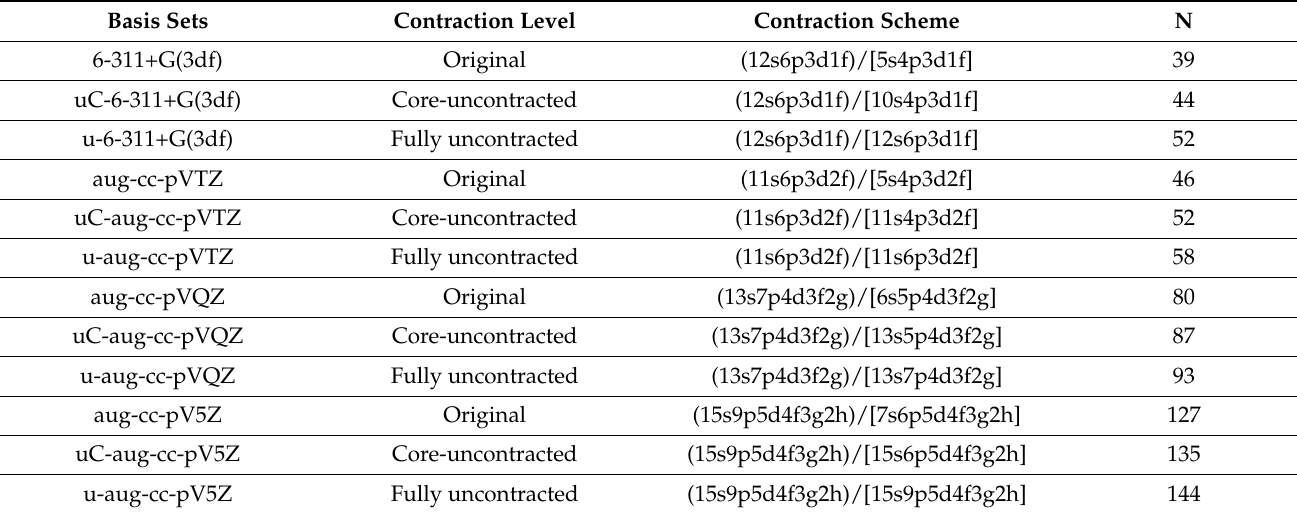
Table 1. Contribution of various basis